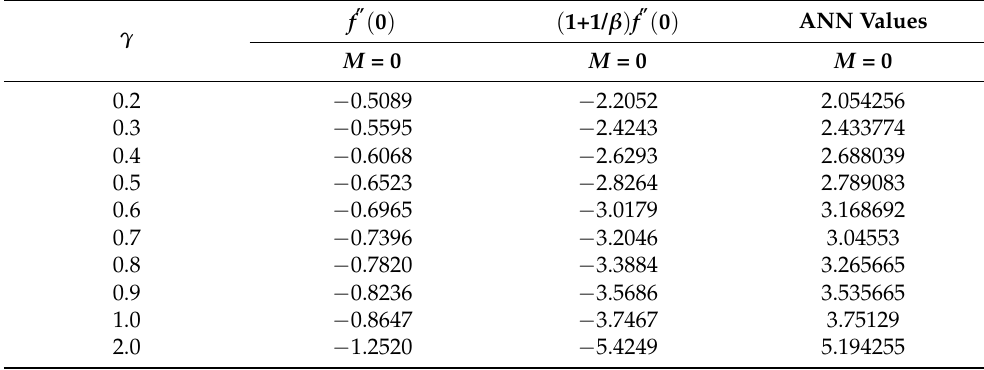
Table 5. Impact of the curvature parameter on the SFC for the nonmagnetic flow